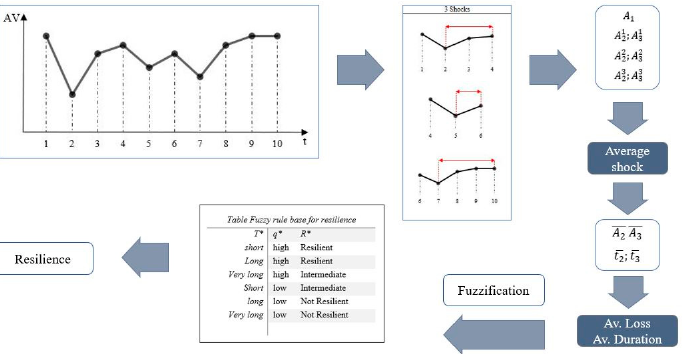
Figure 3. Proposed Model representation.